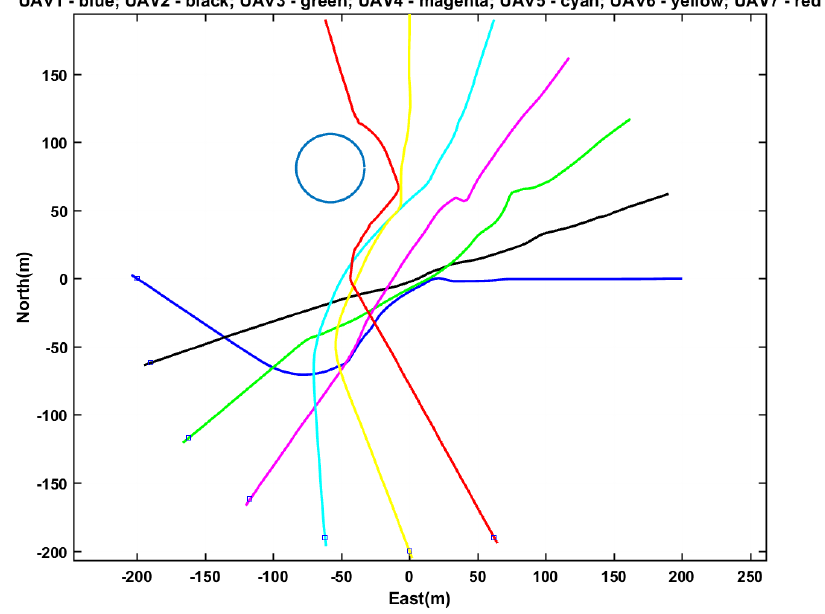
Figure 20. Case 4: Seven UAV control (flight